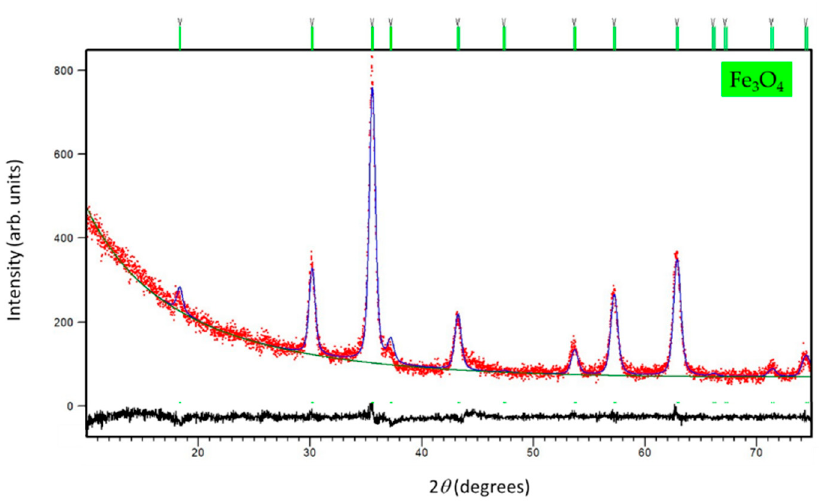
Figure 10. The final observed (red dots), calculated (blue solid line) and difference (black solid line) PXRD profiles of magnetite NPs at RT. The fitted background contribution is represented by the lower green solid line. The upper green tick marks show the reflection positions of the cubic Fe 3 O 4 phase.